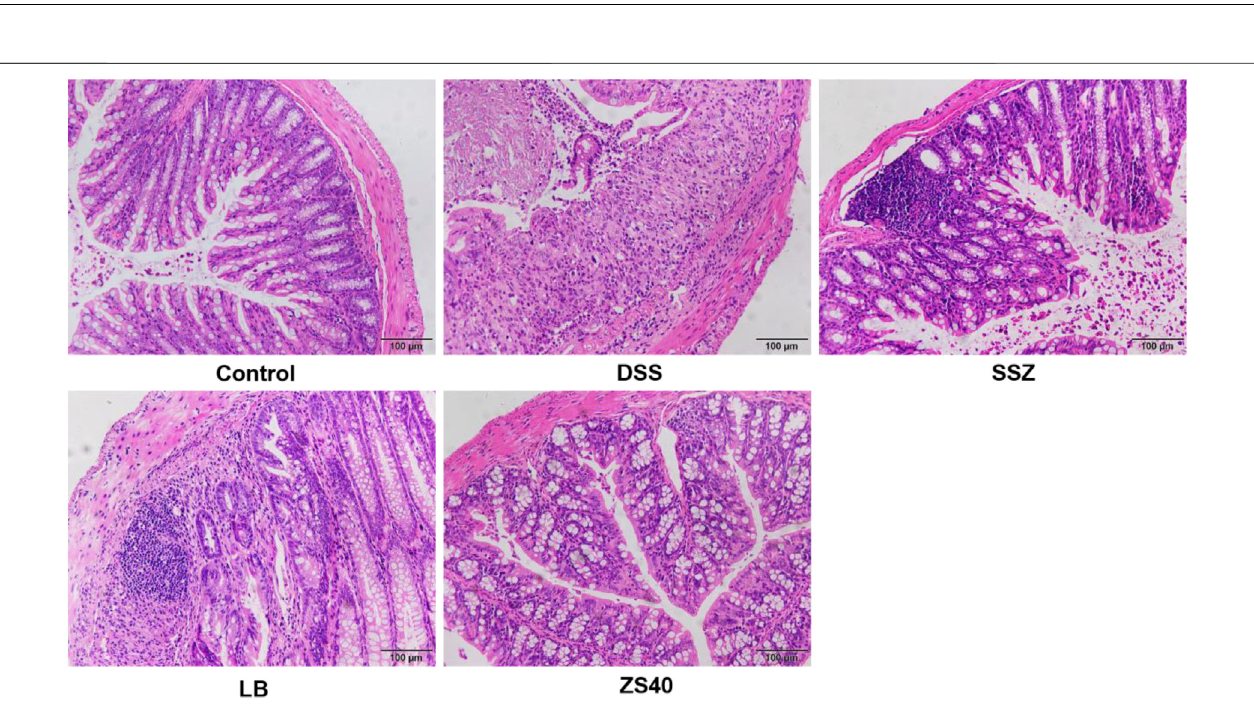
FIGURE 2 | Colon length (cm) of experimental mice. Control group (cid:2) gavage with saline, DSS group (cid:2) 3% dextran sulfate sodium, SSZ group (cid:2) 500 mg/kg body weight (b.w.) salicylazosulfapyridine treatment dose, LB group (cid:2) 1.0 × 10 9 CFU/kg body weight (b.w.) L. bulgaricus treatment dose, ZS40 group (cid:2) 1.0 × 10 9 CFU/kg body weight (b.w.) L. fermentum ZS40 treatment dose. Data are expressed as mean ± SD; ** p < 0.01, **** p < 0.0001 compared with the DSS group.